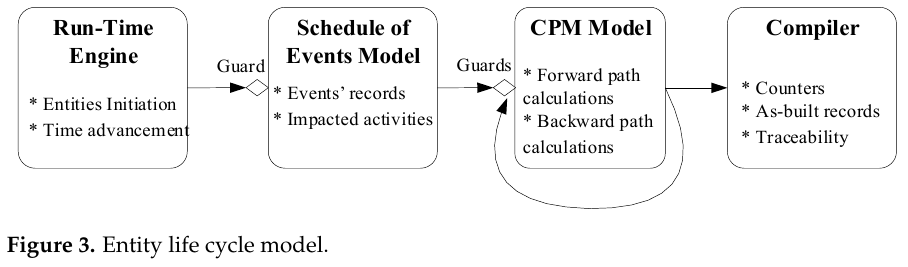
Figure 3. Entity life cycle